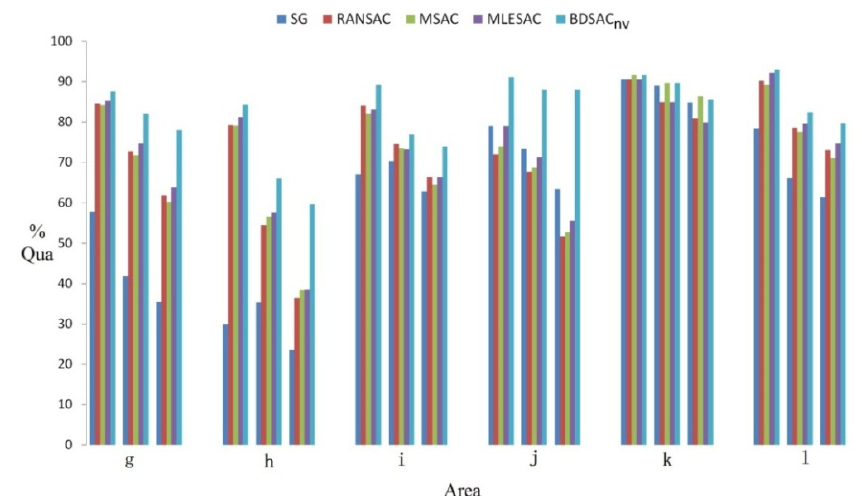
Figure 13. Quantitative results of the Wuhan University data. ( g – l ) are the six areas selected in Figure 12. Three metrics are used, from left to right: quality of segmentation and quality of two ridge based metrics.